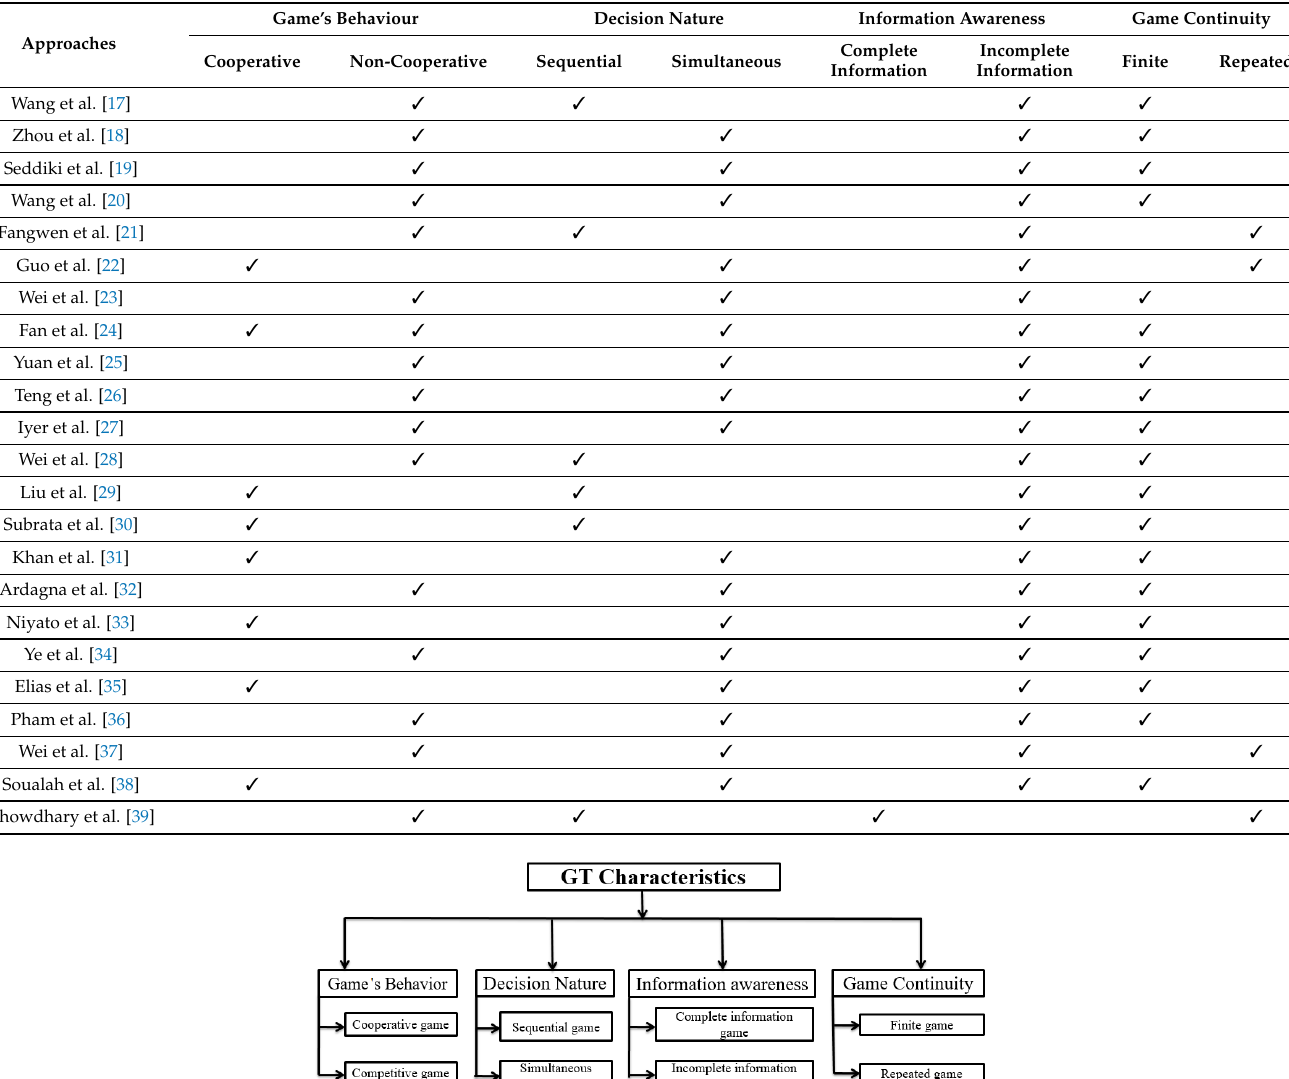
Table 1. GT solutions classification (II).